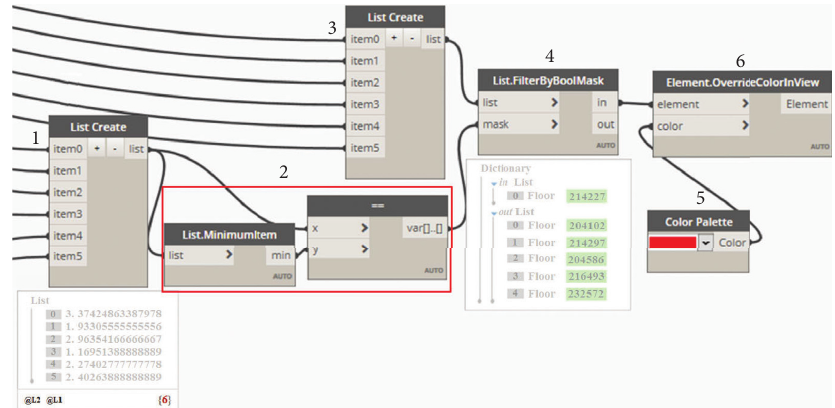
Figure 15: Selection and highlighting of the wearing course with the worst